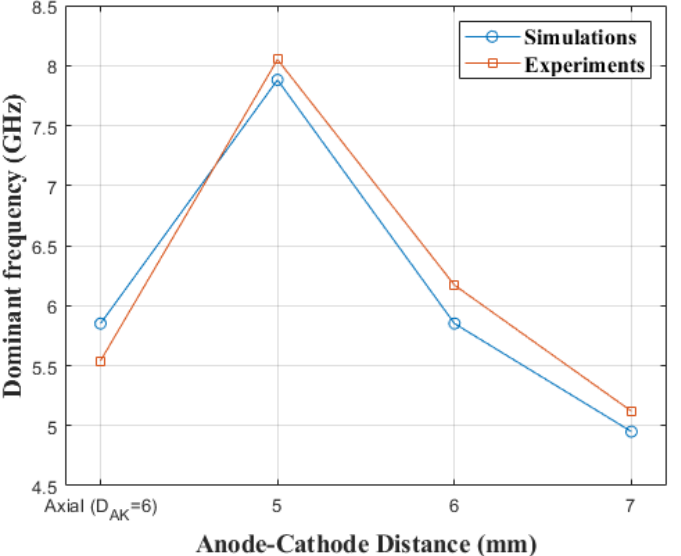
Figure 12. Dominant frequency of the simulations and experiments as a function of the anode to ring reflector distance.